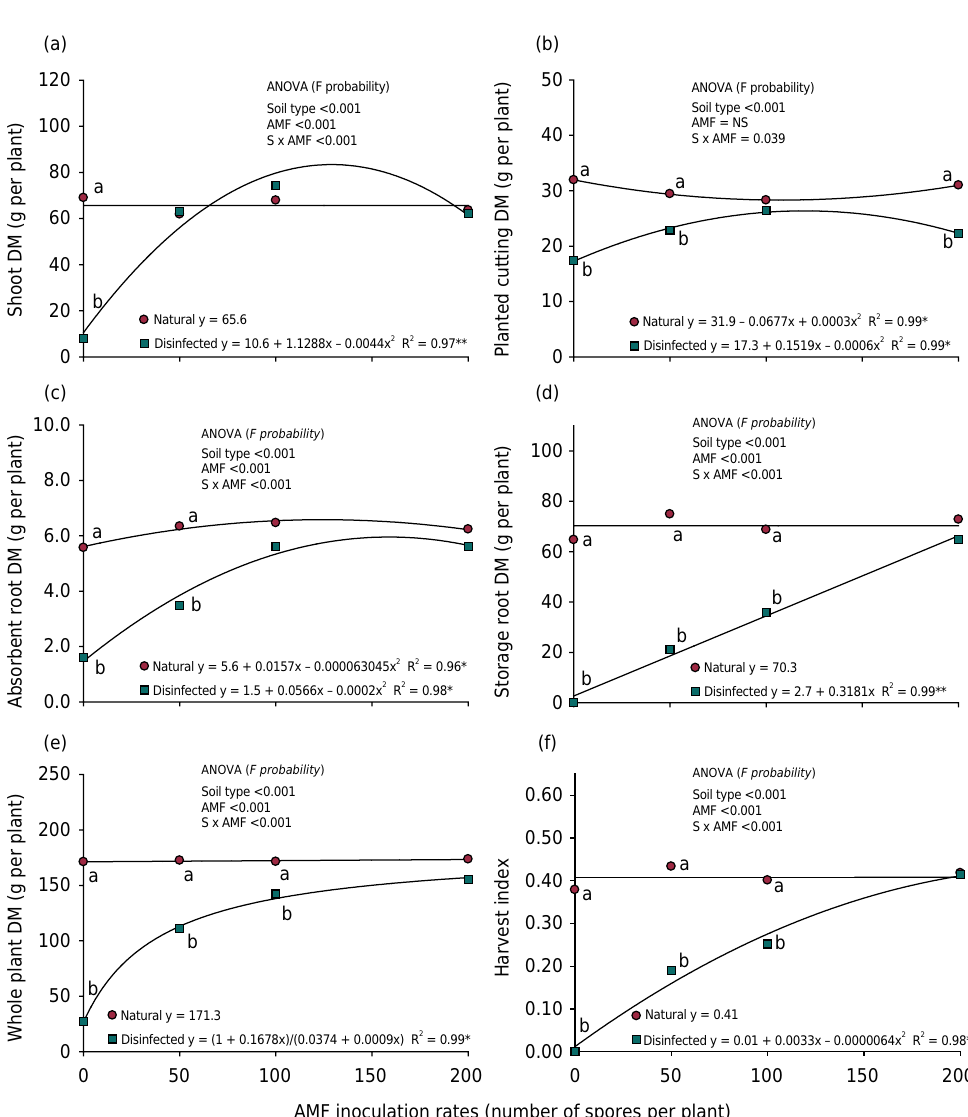
Figure 3. Amounts of dry matter (DM) accumulated in the shoot (a), planted cutting (b), absorbent roots (c), storage roots (d), whole plant (e) and harvest index of the cassava in response to AMF inoculation rates in natural and disinfected soils. Within each AMF inoculation rate, different lowercase letters indicate a significant difference between soil types, whereas the absence of lowercase letters indicates a non-significant difference between soil types at p≤0.05. * p≤0.05; **